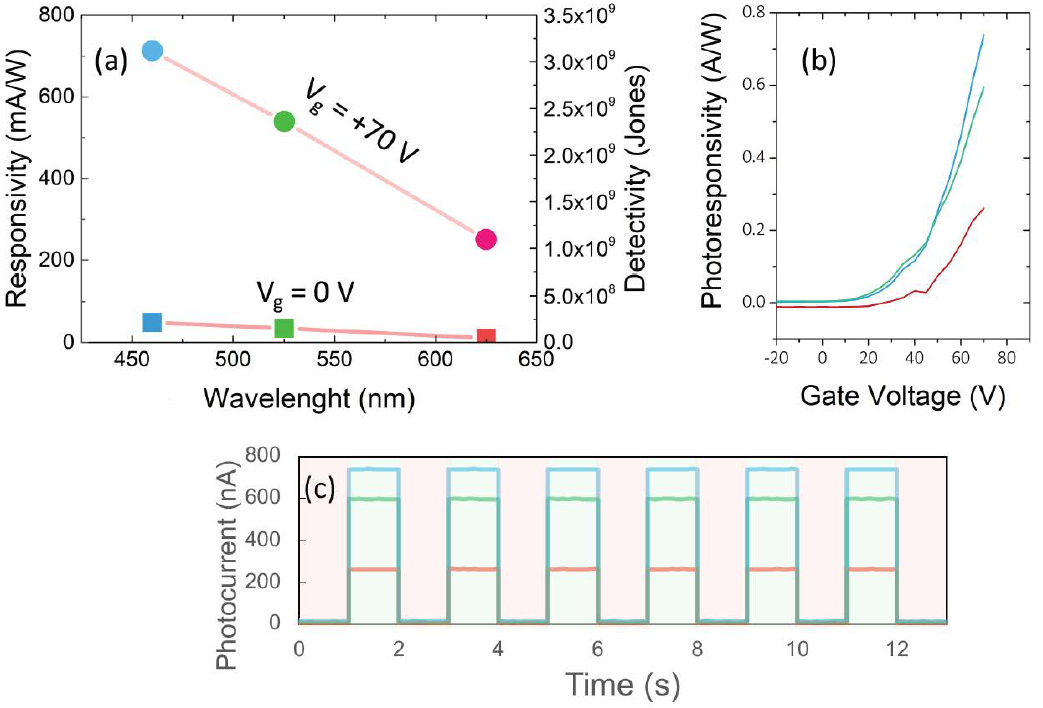
Figure 4. ( a ) photoresponsivity and photodetectivity of the device under light irradiation by applying and without applying gate voltage; ( b ) photoresponsivity versus gate voltage under red, green and blue light irradiation ( c ) photocurrent of the device under pulsed applying gate voltages at different wavelength irradiation (green is applying +70 V gate voltage and red is without gate